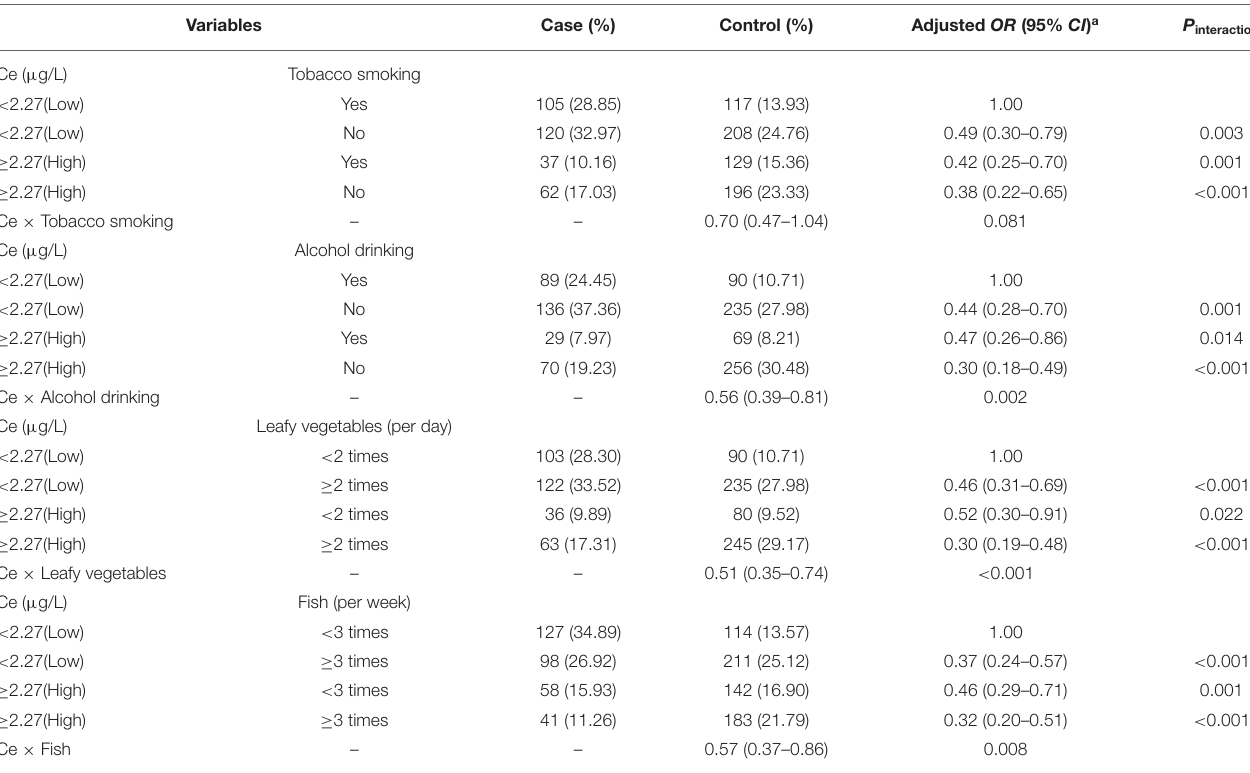
TABLE 3 | Combined effect of the serum levels of Ce and tobacco smoking, alcohol drinking or intake of leafy vegetables or fish for oral cancer.